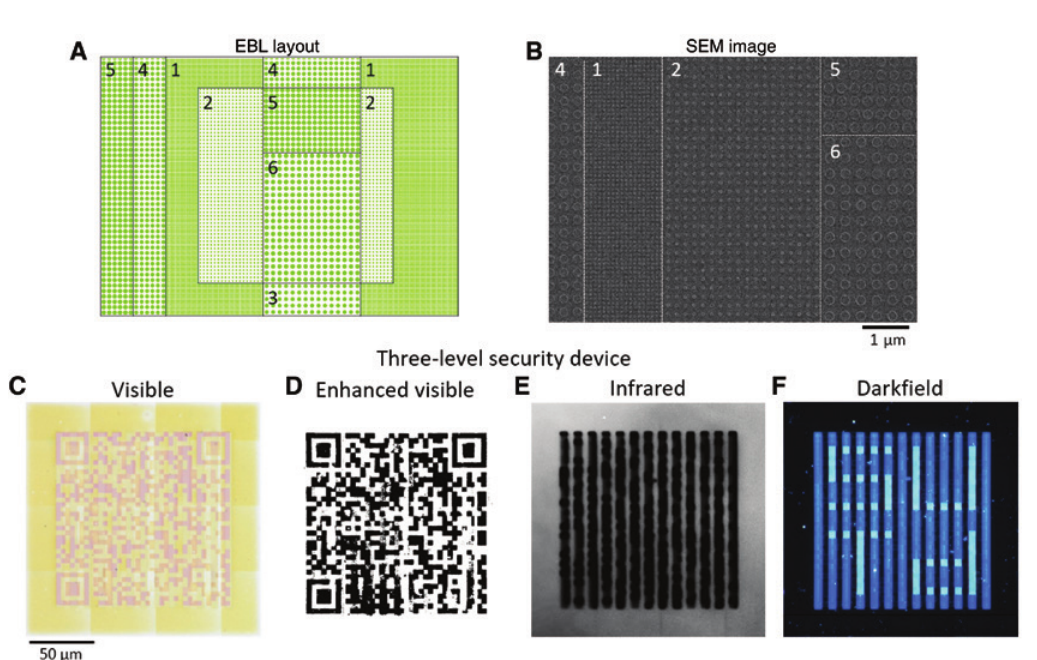
Figure 5: Multi-level optical micro-tag. (A) Section of EBL layout of disks used for patterning. (B) SEM image of small region of fabricated tag. (C) Brightfield visible, (D) infrared, (E) x -polarized darkfield visible, and (F) y -polarized darkfield visible images of fabricated four-level security